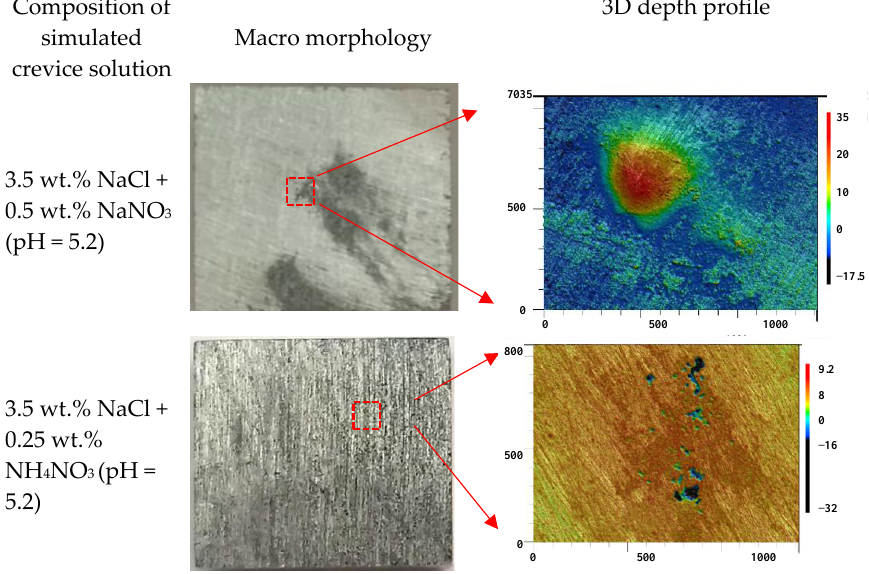
Figure 11. The macro morphology and 3D depth profiles of specimens in simulated crevice solution after corrosion for 24 h.